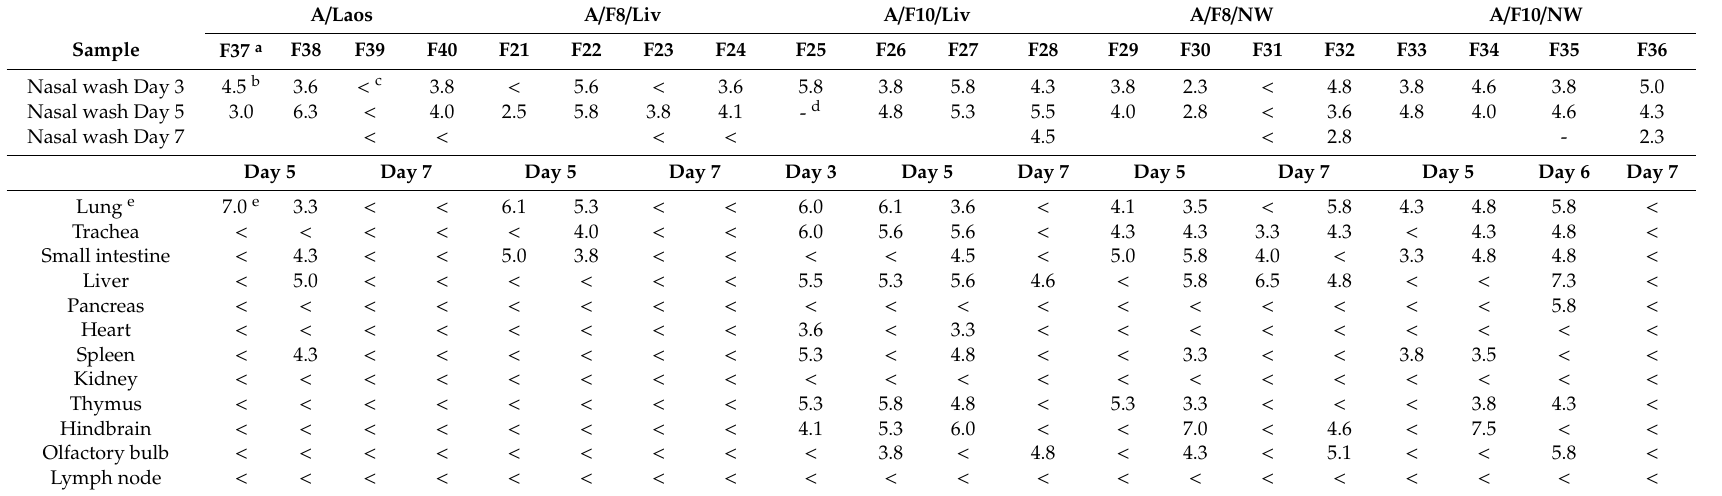
Table 6. Ferret-passaged H5N1 isolates encoding PB2 627K produce a more widespread systemic infection upon a second virus passage in